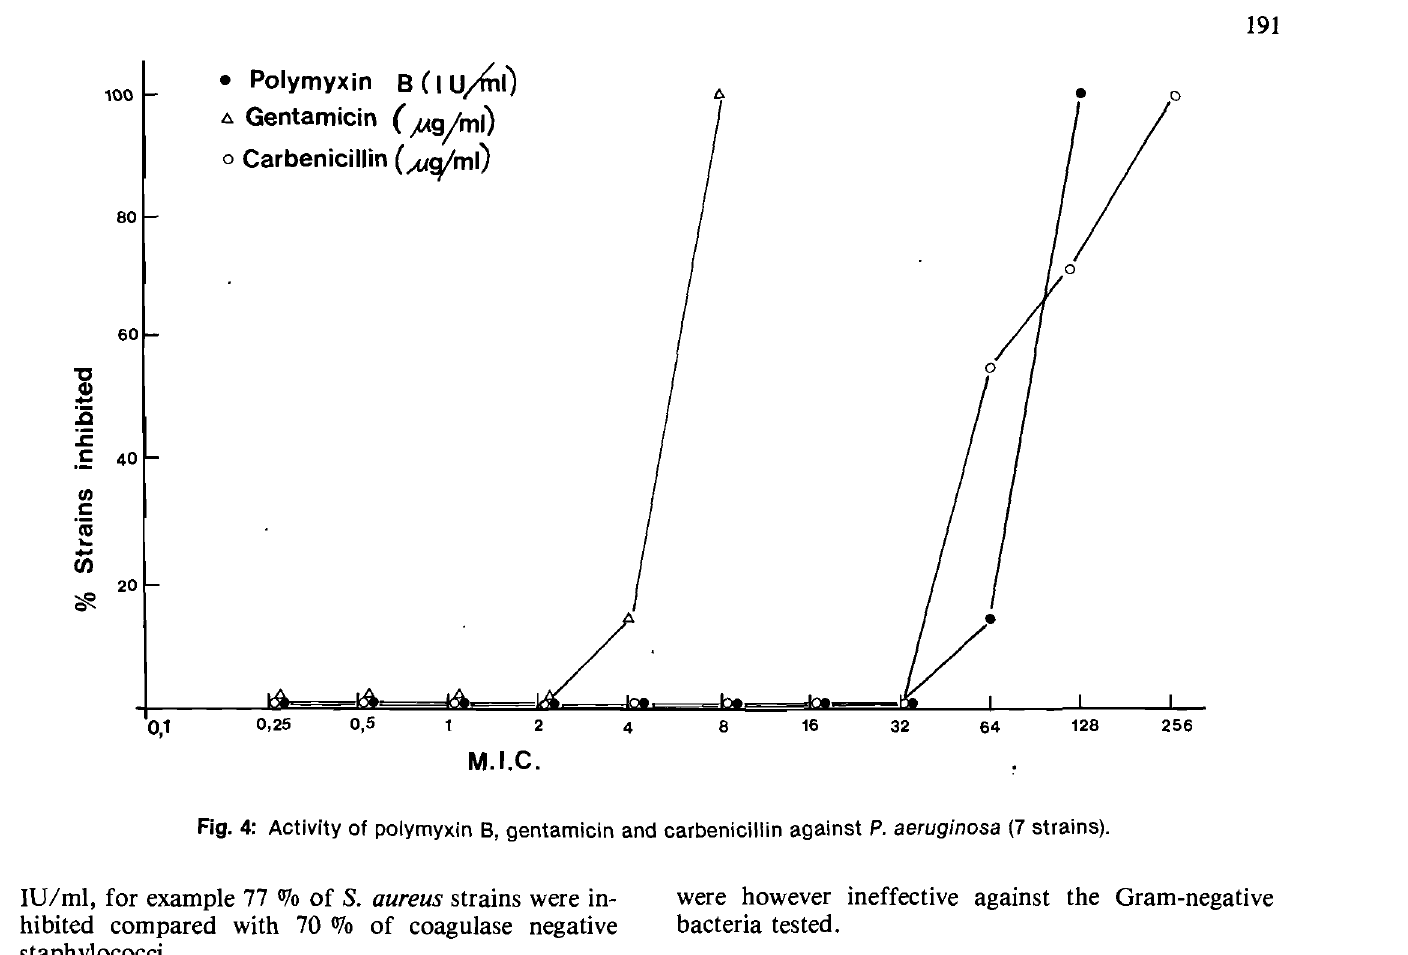
Fig. 4: Activity of polymyxin B, gentamicin and carbenicillin against P. aeruginosa (7 strains). IU/ml, for example 77 CTfo of S. aureus strains were in